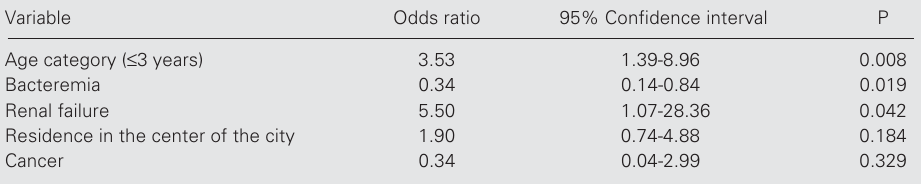
Table 2. Factors associated with infection by penicillin-nonsusceptible Streptococcus pneumoniae : multivari- ate